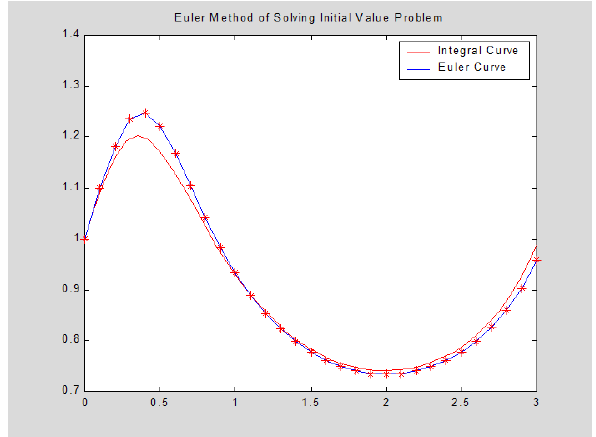
Fig. 2 Numerical solution based on the improved Euler